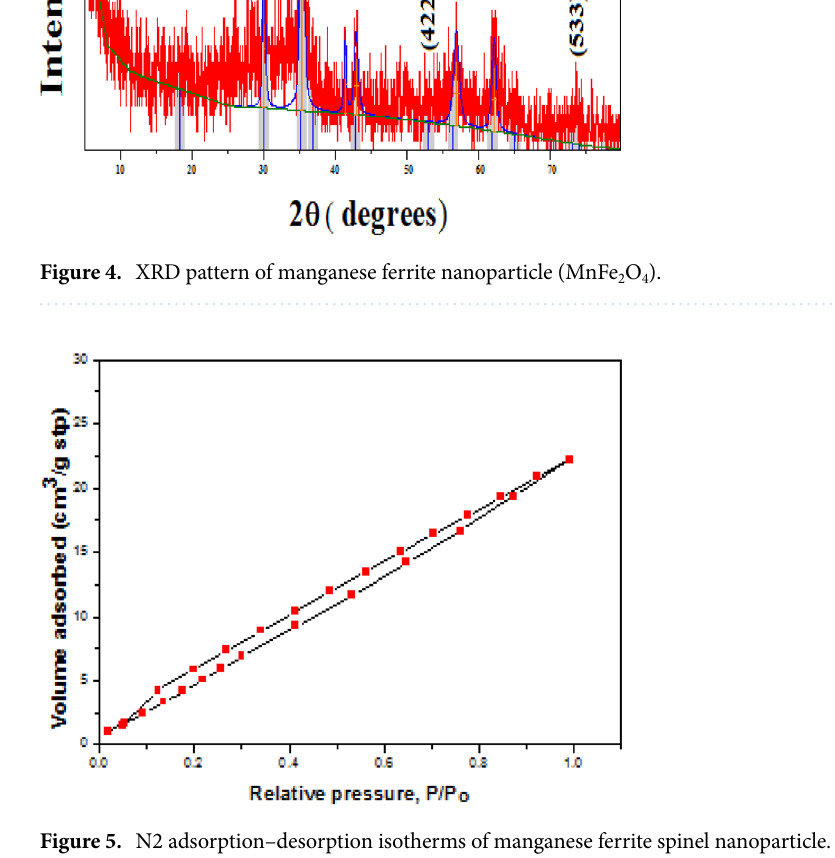
Figure 5. N2 adsorption–desorption isotherms of manganese ferrite spinel nanoparticle.